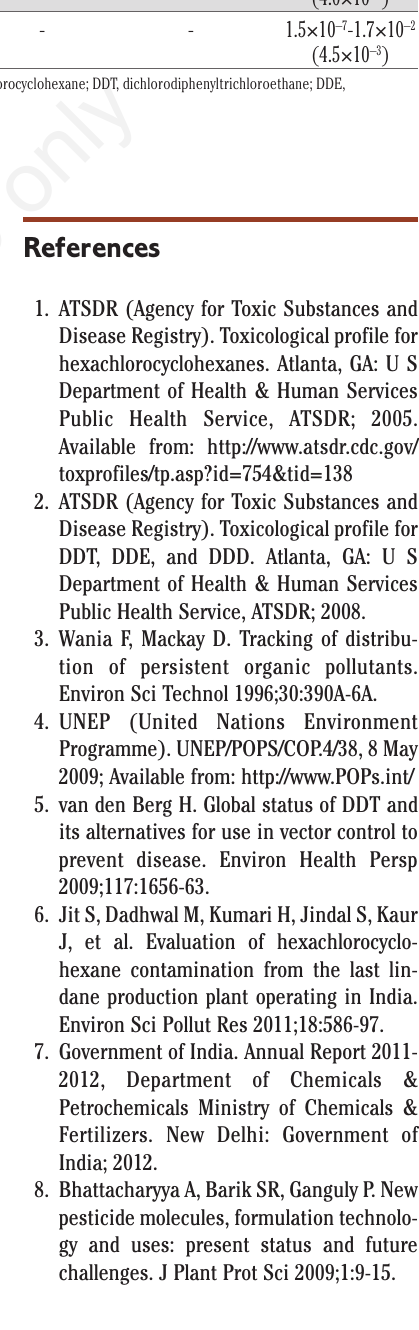
Table 4. Non-carcinogenic health hazard and hazard index for humans from hexachlorocyclohexane and dichlorodiphenyl- trichloroethane through vegetables. Vegetables Non-cancer HQs of pesticide compounds HI (no.)* α -HCH Carrot Cauliflower Eggplant Radish Spinach